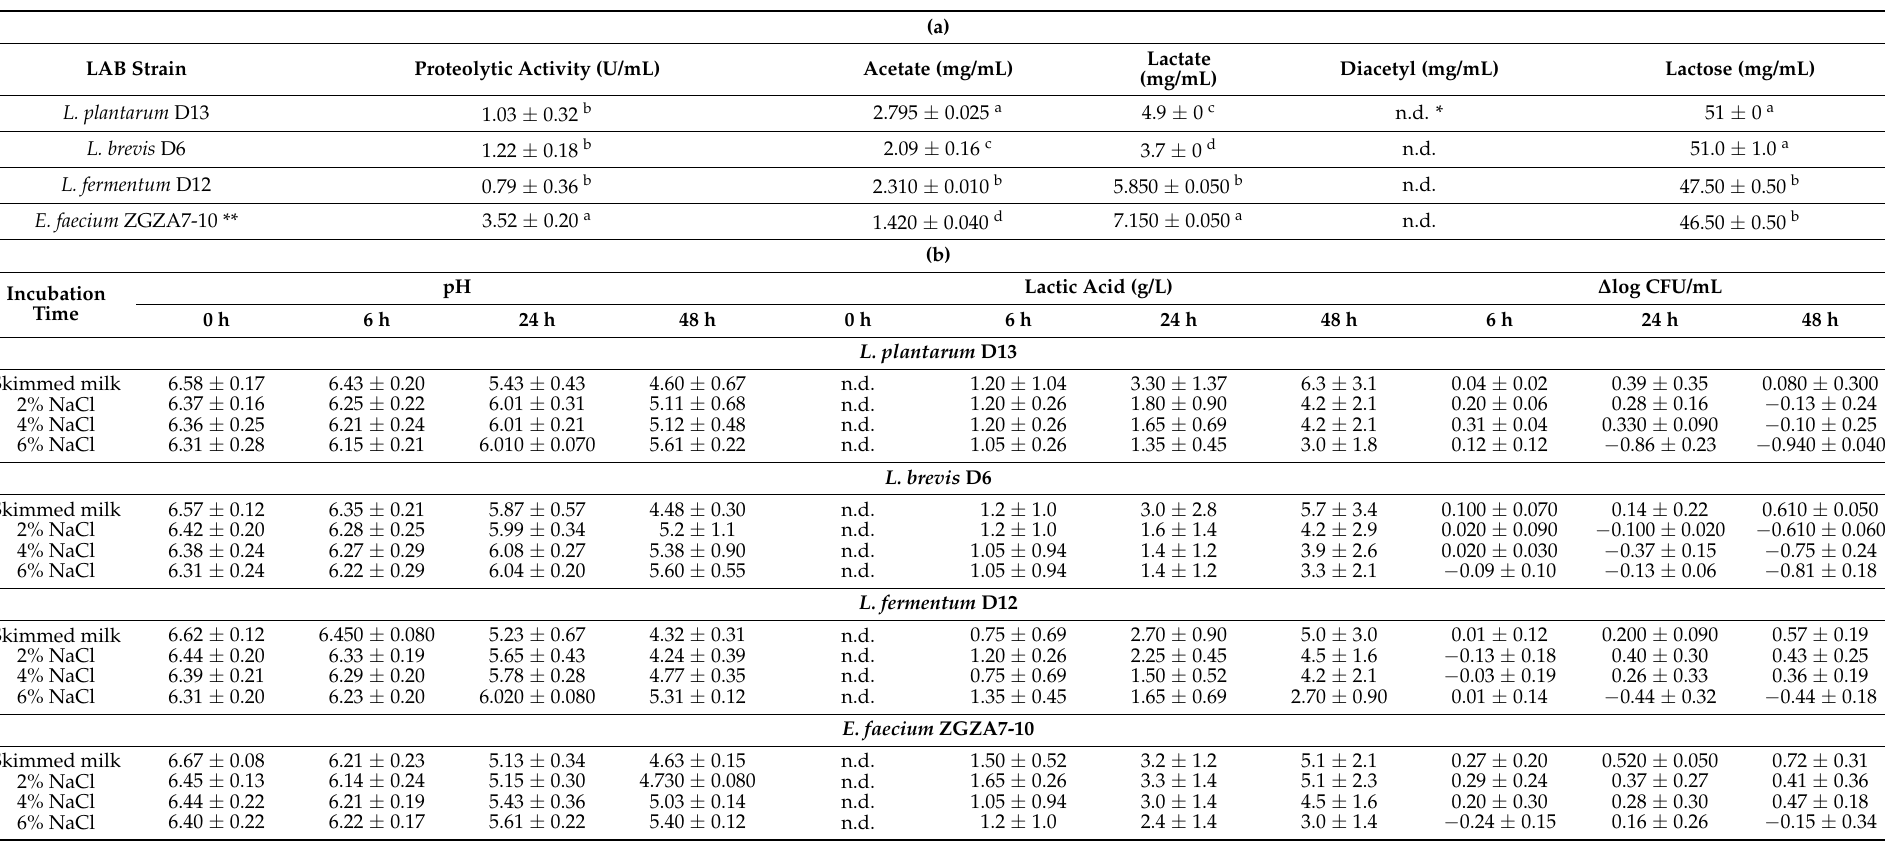
Table 1. ( a ) Proteolytic activity determined by Anson’s method and lactate, acetate, diacetyl and lactose concentrations after overnight growth of single strains of the lactic acid bacteria (LAB) consortium in skimmed milk. ( b ) pH values and lactic acid (g/L) of the culture supernatants of single strains of the LAB consortium at 0, 6, 24 and 48 h of cultivation in skimmed milk with or without NaCl addition in concentrations of 2, 4 and 6% ( w / v ), as well as LAB counts expressed as the difference of logarithmic values during cultivation ( ∆ log